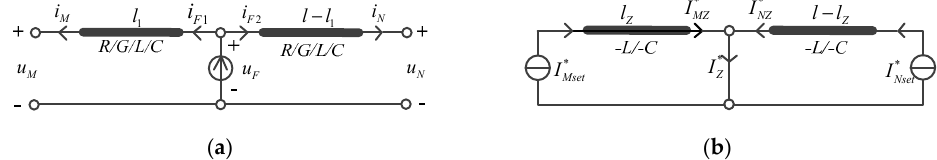
Figure 2. Justification for fault location that uses time reversal theory with two internal observers: ( a ) the additional network after fault occurrence; ( b ) calculate the current of assumed fault along the lossless mirror line.